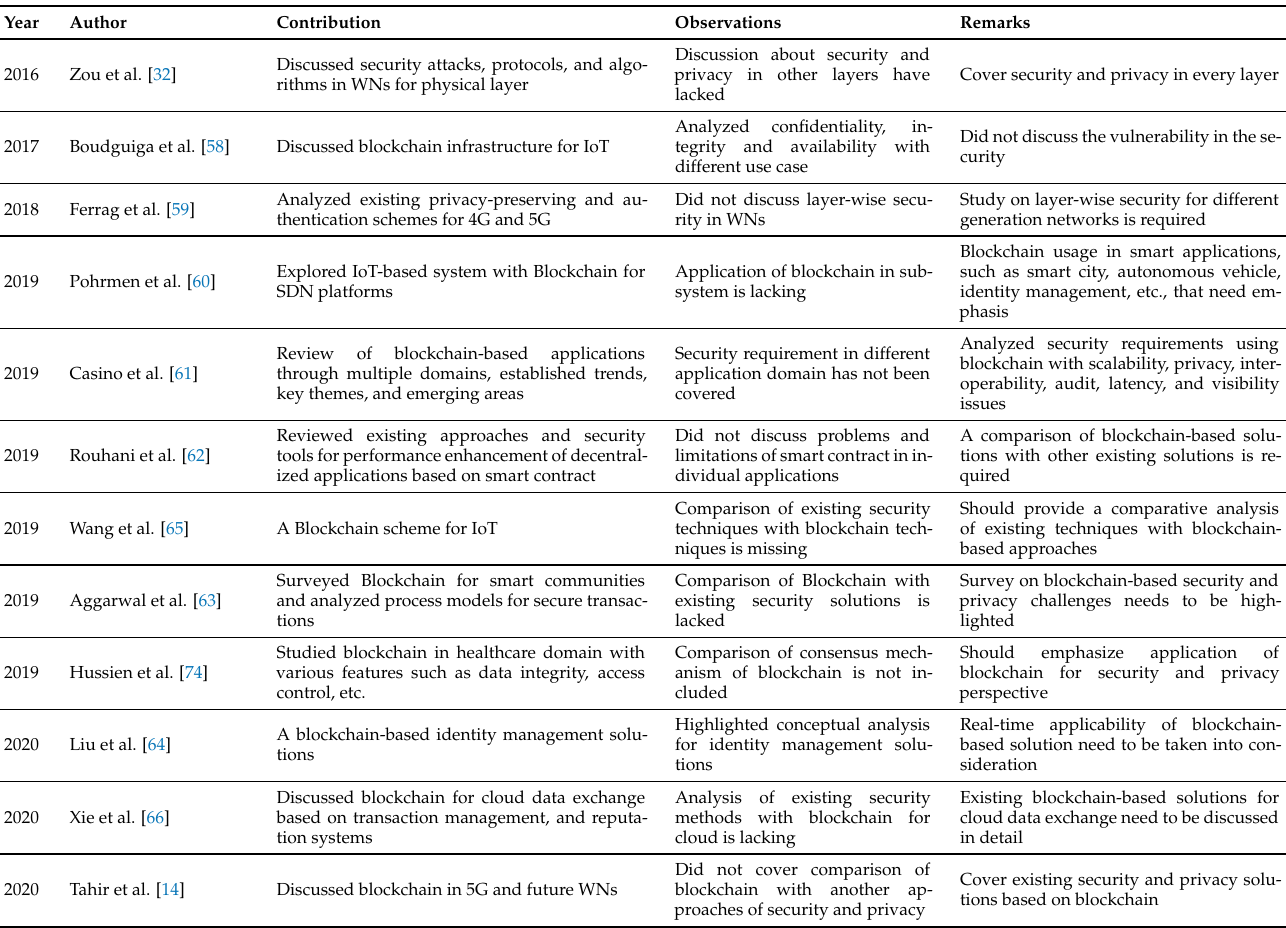
Table 1. A comparative analysis of the existing survey with the proposed study on the blockchain- based solutions for the security and privacy issues in